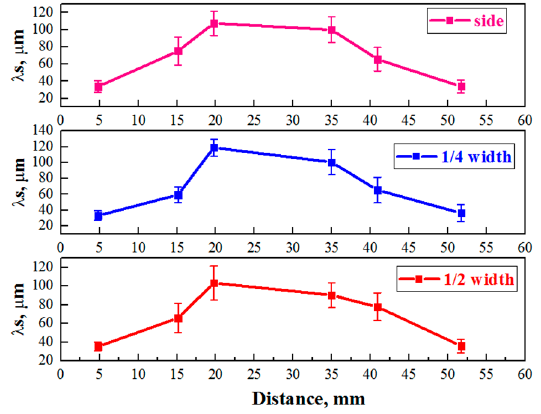
Figure 6. SDAS from surface to the center of slabs.